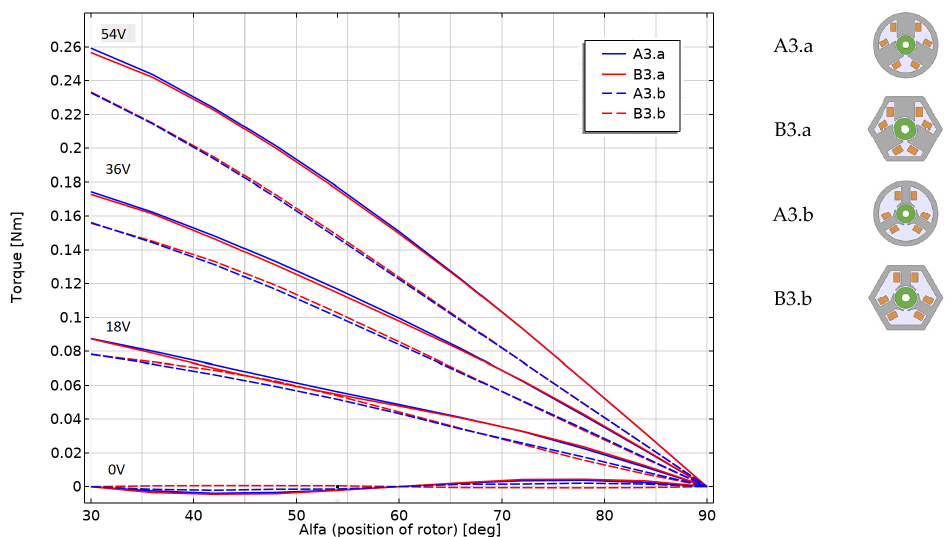
Figure 16. Axial torque for various models from the A3._ and B3._ group calculated for the angular position of the rotor from 30° to 90° for different supply voltages.